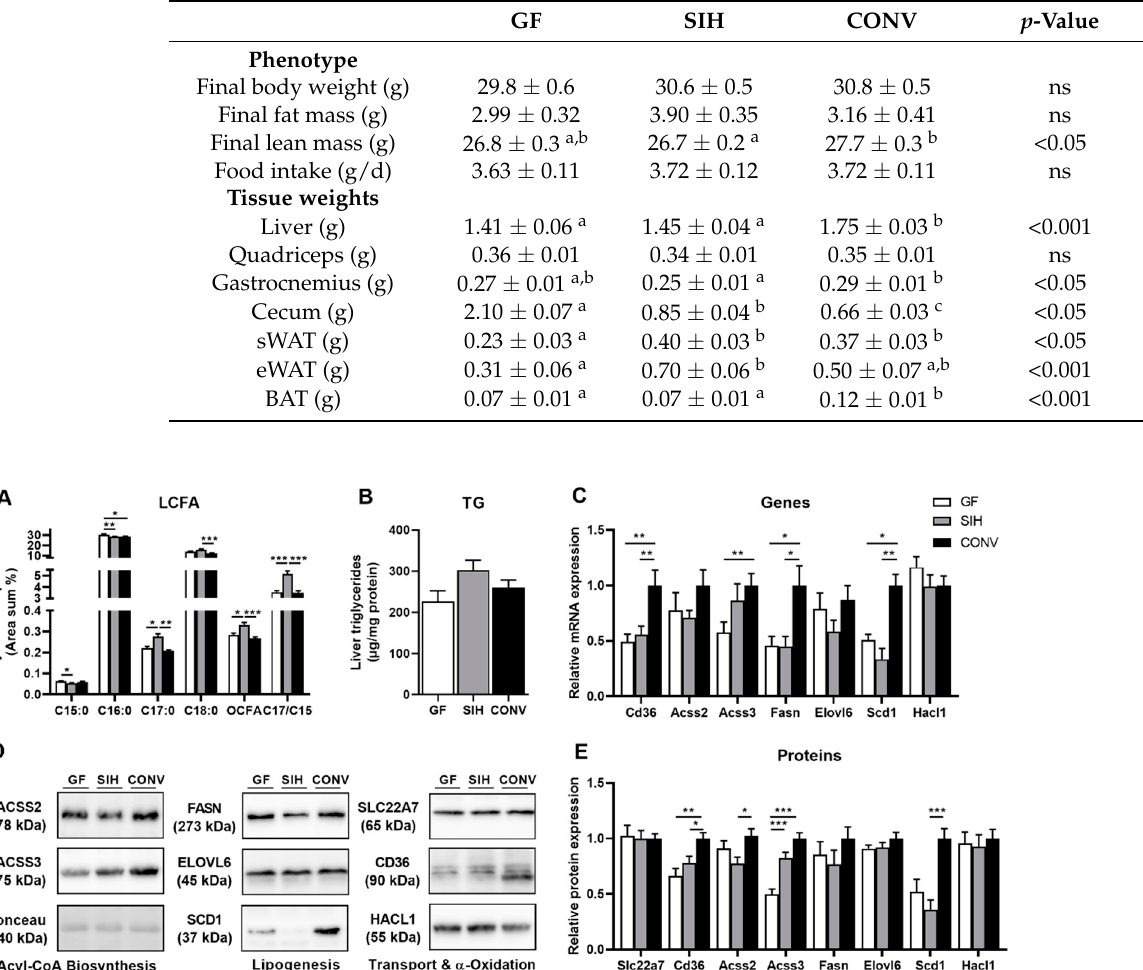
Table 2. Phenotypical changes in male 16-week-old C3H/HeOuJ mice with different colonization states fed a high-fat + inulin diet (HFI) for 4 weeks. GF = germ-free mice, SIH = SIHUMI mice, CONV = conventional mice. Data are mean +/ − SEM ( n = 10). Different letters indicate significant differences between groups.